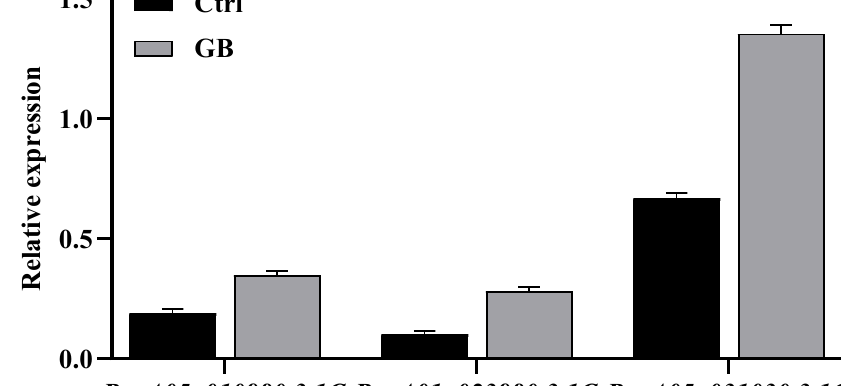
Figure 7. Gene expression pattern verification by qRT-PCR. A. Three genes for HSP20: BraA03g005240.3.1C , 17.6 kDa class II heat shock protein; BraA01g018430.3.1C , heat shock protein 21 (chloroplastic); BraA01g015830.3.1C , 23.6 kDa heat shock protein (mitochondrial). B. Three genes for antioxidant enzymes: BraA05g010980.3.1C , peroxidase 19; BraA01g023980.3.1C , peroxidase 34; BraA05g031030.3.1C , peroxidase 29 C. Three genes of other pathway genes: BraA08g025430.3.1 , glucose-6-phosphate 1-dehydrogenase 3 (chloroplastic); BraA03g050640.3.1C , 5’-adenylylsulfate reductase 3 (chloroplastic); BraA04g029450.3.1C , abscisic acid receptor PYL6.